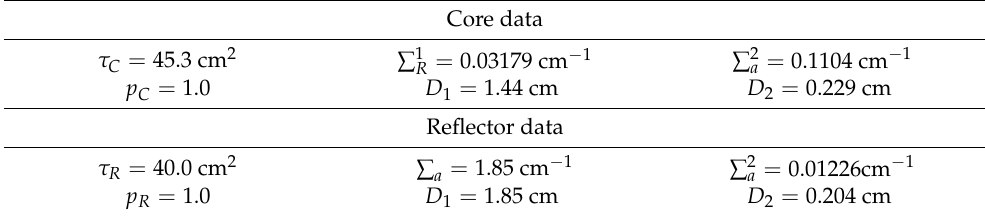
Table 11. Two-group reflected reactor cross-sections